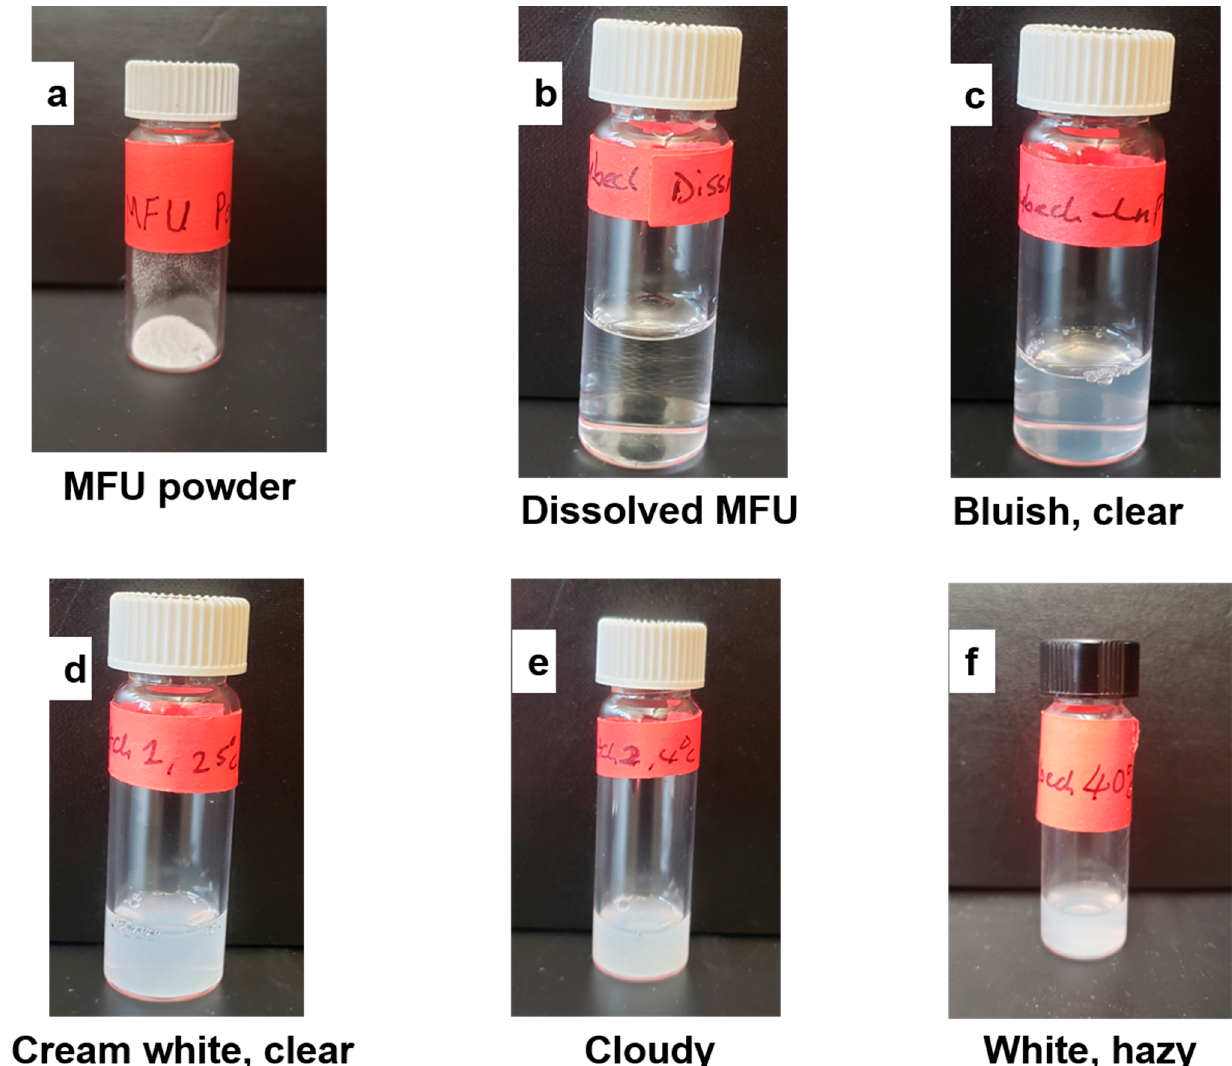
Figure 1. Physical appearance of Zhubech stored in (20 mL borosilicate clear Type 1, class A) glass vials over time. ( a ) Powdered appearance of MFU after synthesis, ( b ) MFU dissolved in distilled water to form a solution, ( c ) bluish, clear appearance after formulating Zhubech, ( d ) cream white, clear appearance of batch 1 formulation at all temperatures, ( e ) cloudy appearance of batches 2 and 3 stored at 4 °C, and ( f ) white hazy appearance of batches 2 and 3 stored at 40 °C.